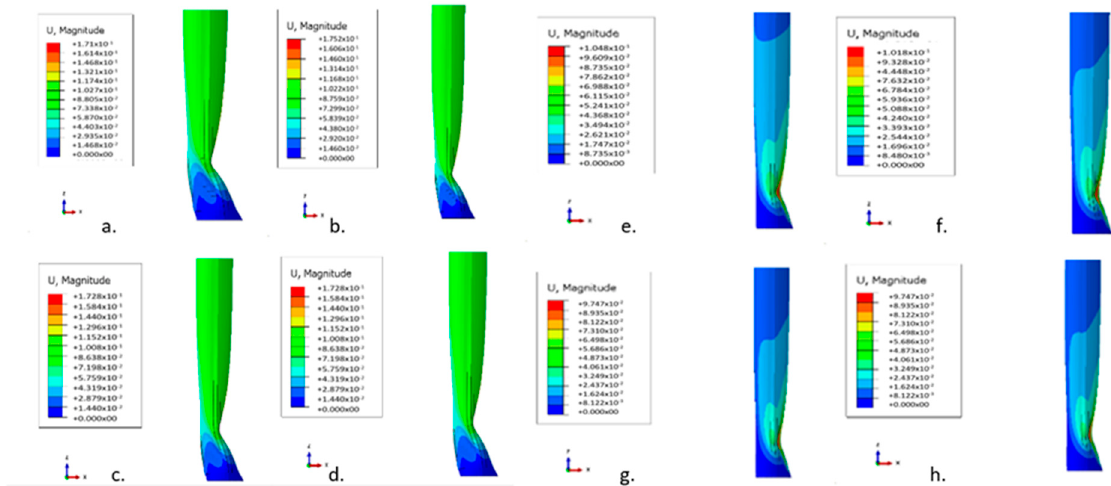
Figure 5. Street pole deformation with TDM reinforcement. ( a – d ) are deformation after a frontal collision on a street pole with thicknesses of 15, 25, 35 and 45 mm, respectively, while ( e – h ) are deformation after a corner collision on a street pole with thicknesses of 15, 25, 35 and 45 mm, re- spectively.